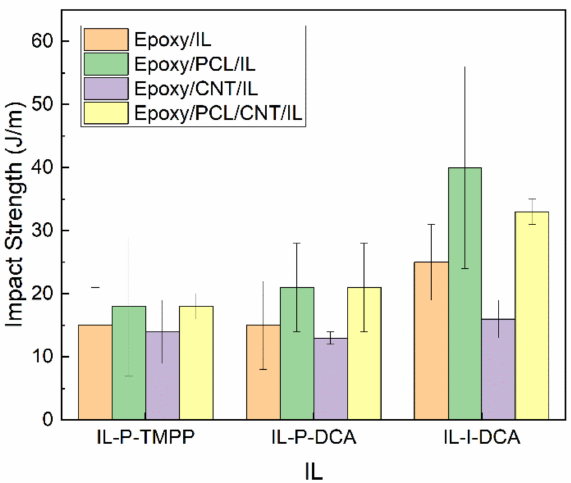
Figure 8. The impact strength of the epoxy/PCL/CNT NCs cured with the three different ILs, as well as that of the reference epoxy/IL, epoxy/PCL/IL and epoxy/CNT/IL